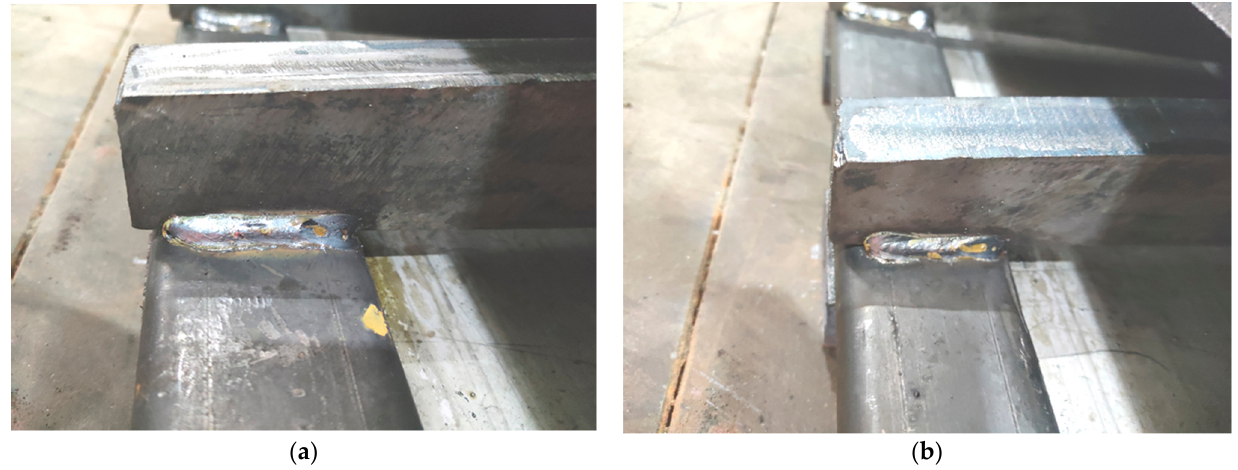
Figure 25. Welds of steel groove and support system: ( a ) From top to bottom in Figure 22b, Below the third teeth, ( b ) Below the fourth teeth.